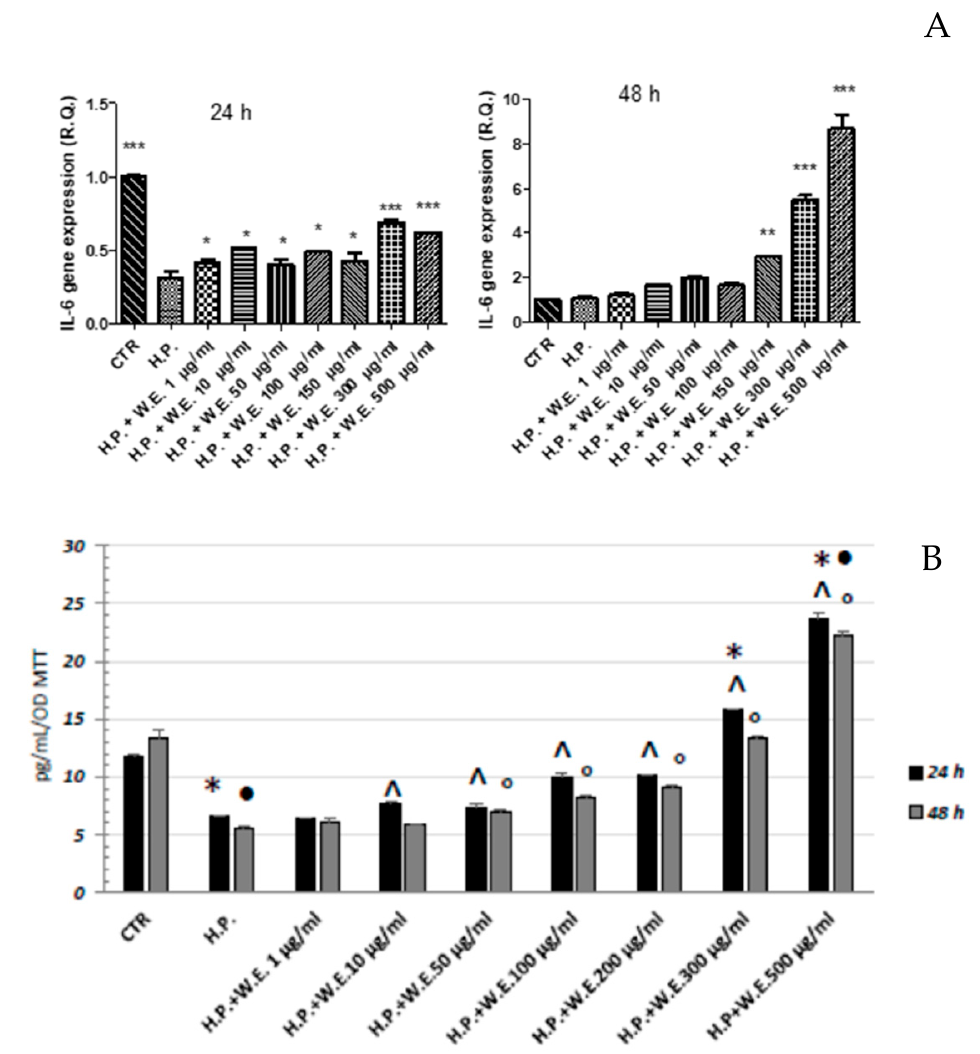
Figure 6. Modulatory effects induced by Futura 75 water extract on hydrogen peroxide (H.P.) 300 µ M gene expression ( A ) and release ( B ) of interleukin (IL)-6, in human keratinocytes. n = 3. ANOVA, p < 0.0001; *** p < 0.001, ** p < 0.01, * p < 0.05 vs. respective H.P. group B * p < 0.05 vs. Ctr 24 h; • p < 0.05 vs. Ctr 48 h; ˆ p < 0.05 vs. H.P. 24 h; ◦ p < 0.05 vs. H.P. 48 h.